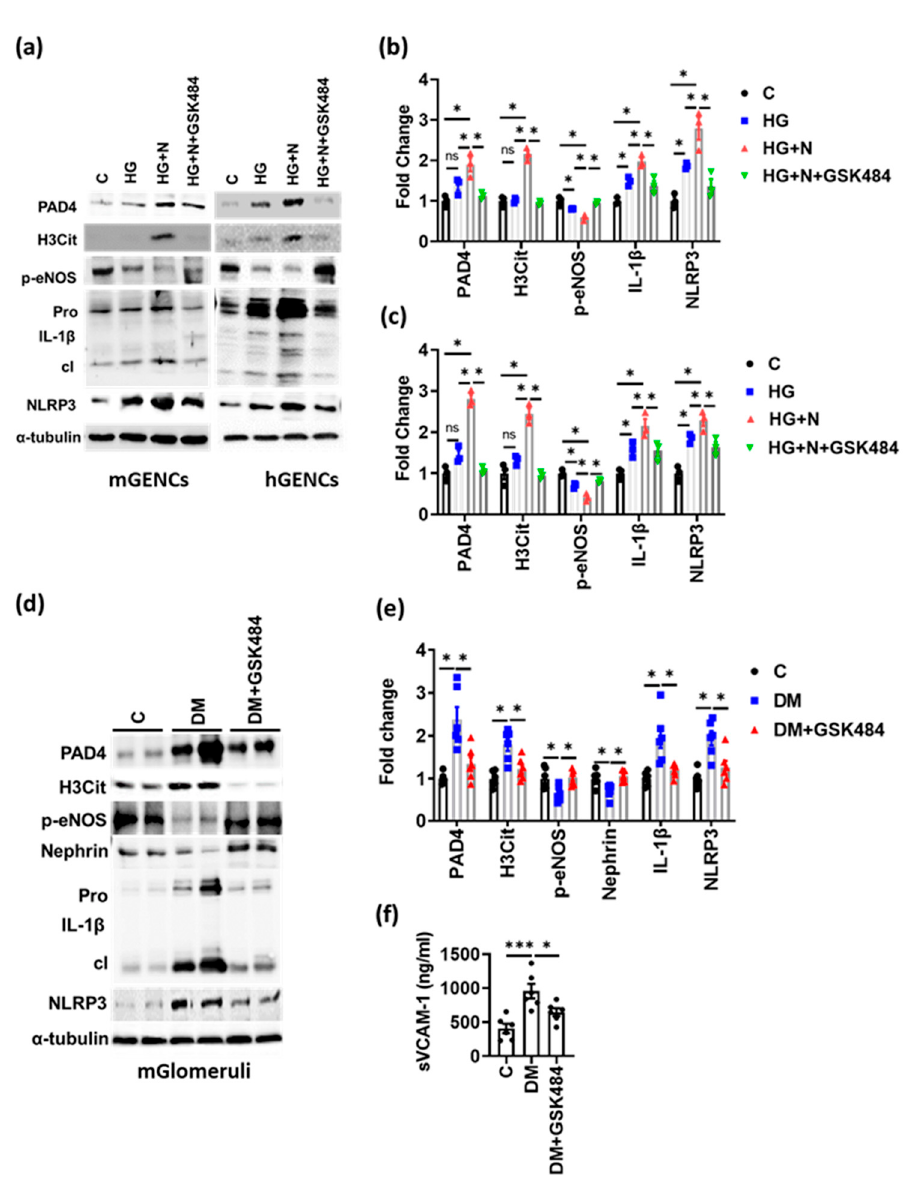
Figure 4. PAD4 inhibition ameliorates inflammasome activation and endothelial dysfunction. ( a – c ) Representative immunoblots (( a ); bar graph summarizing results: ( b , c )) of mGENC ( a , b ) and hGENC ( a , c ) showing the expression of marker genes for NETs (PAD4, H3Cit), inflammasome activation (IL ‐ 1 β : cleaved form—cl, inactive preform—Pro; NLRP3) and endothelial dysfunction (p ‐